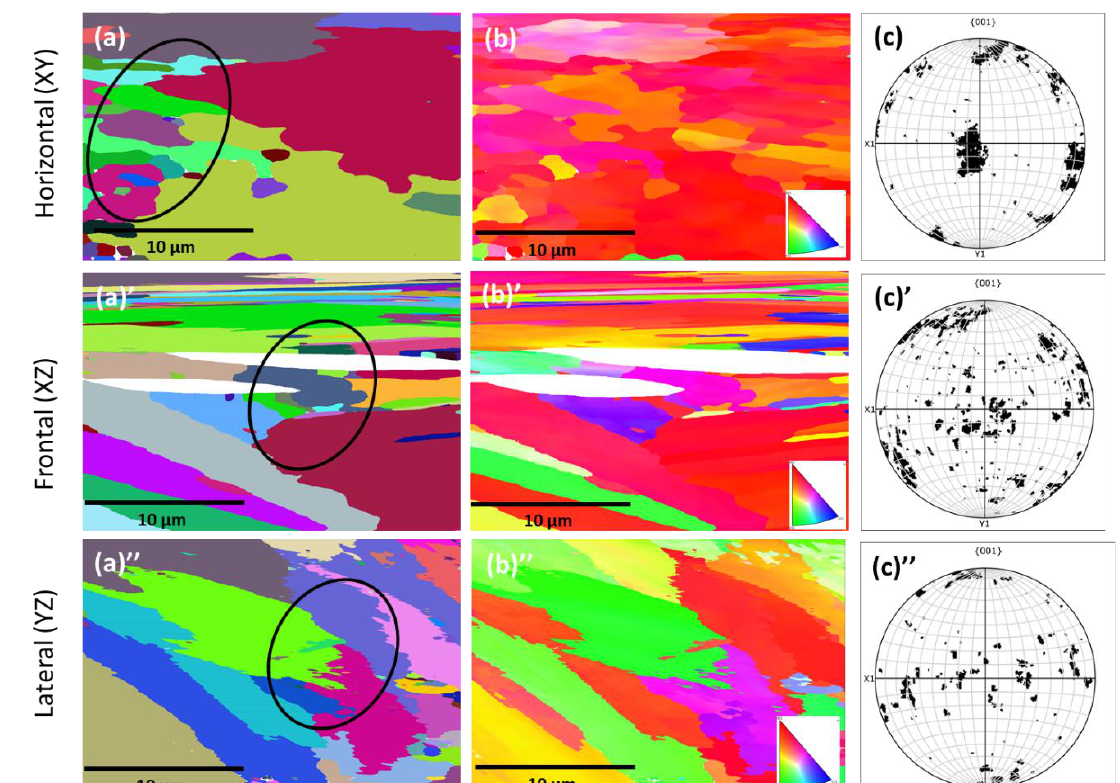
Figure 4. Grain boundary (GB) ( a , a’ , a’’ ), inverse pole figure (IPF) ( b , b’ , b’’ ) and pole figure (PF) ( c , c’ , c’’ ) maps on the L-PBF-processed Inconel 718 alloy: ( a – c ) horizontal, ( a’ , b’ , c’ ) frontal and ( a’’ – c’’ ) planes in relation to the build direction (BD). The black circles indicate the area where changes in gain orientation took place.